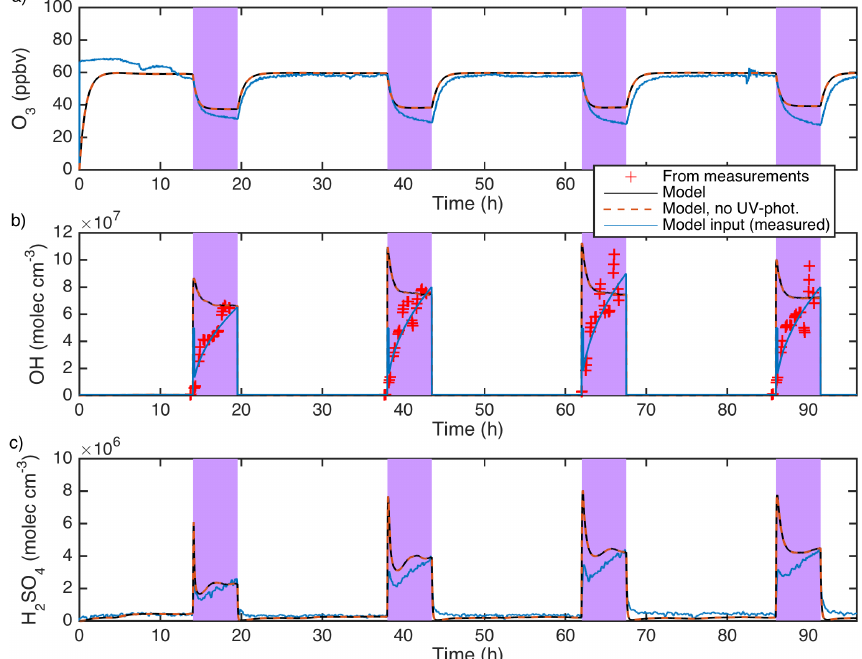
Figure 4. Measured and modelled (a) O 3 concentrations, (b) OH concentration, and (c) H 2 SO 4 concentration. The OH concentration (red + ) was not measured directly but was derived from the observed 2-butanol loss rate. The model results are from the simulations where the O 3 , OH and H 2 SO 4 concentrations were simulated by the model instead of given as the input concentration to the model. The results given by the orange dashed line corresponds to a simulation where the 254 nm UV light was only used to calculate the photolysis rates of O 3 but not influencing photolysis rates of the other compounds. In the model simulations, we used the empirically determined JPAC reaction chamber-specific OH sink of 4s − 1 and an O 3 concentration of 170ppbv in the inflow to the chamber. The blue lines give the model input concentrations that were used for the simulations presented in Sect. 4. For O 3 and H 2 SO 4 , the model input concentration was taken directly from the